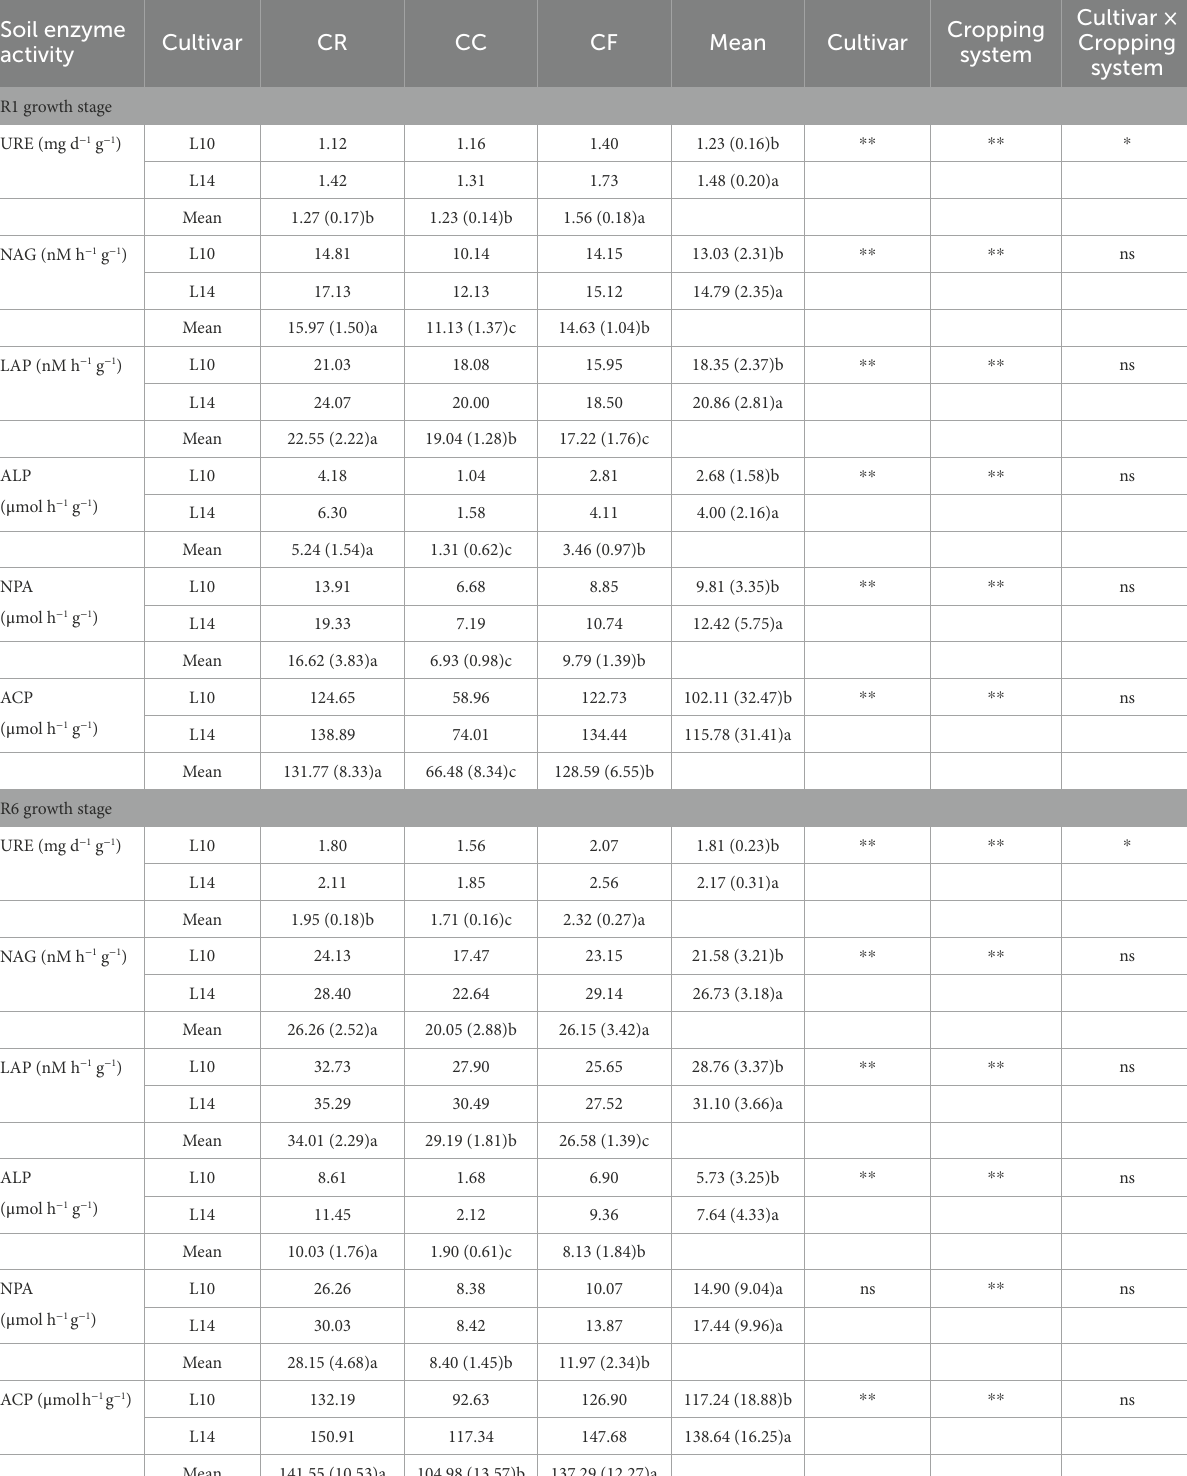
TABLE 2 Effects of crop rotation and continuous cropping on soil enzyme activity parameters. Soil enzyme Cultivar CR CC activity